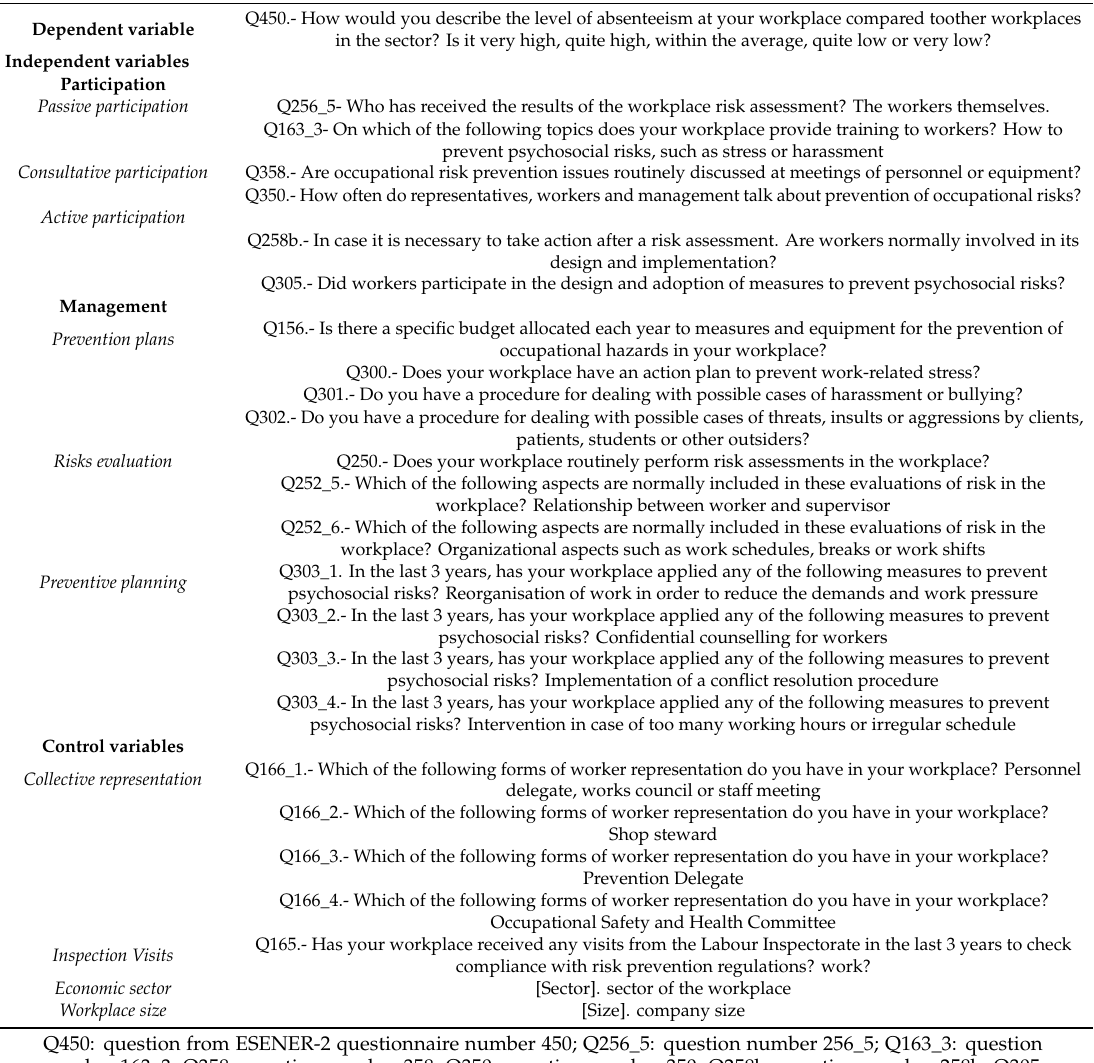
Table 1. Varibles Included in The